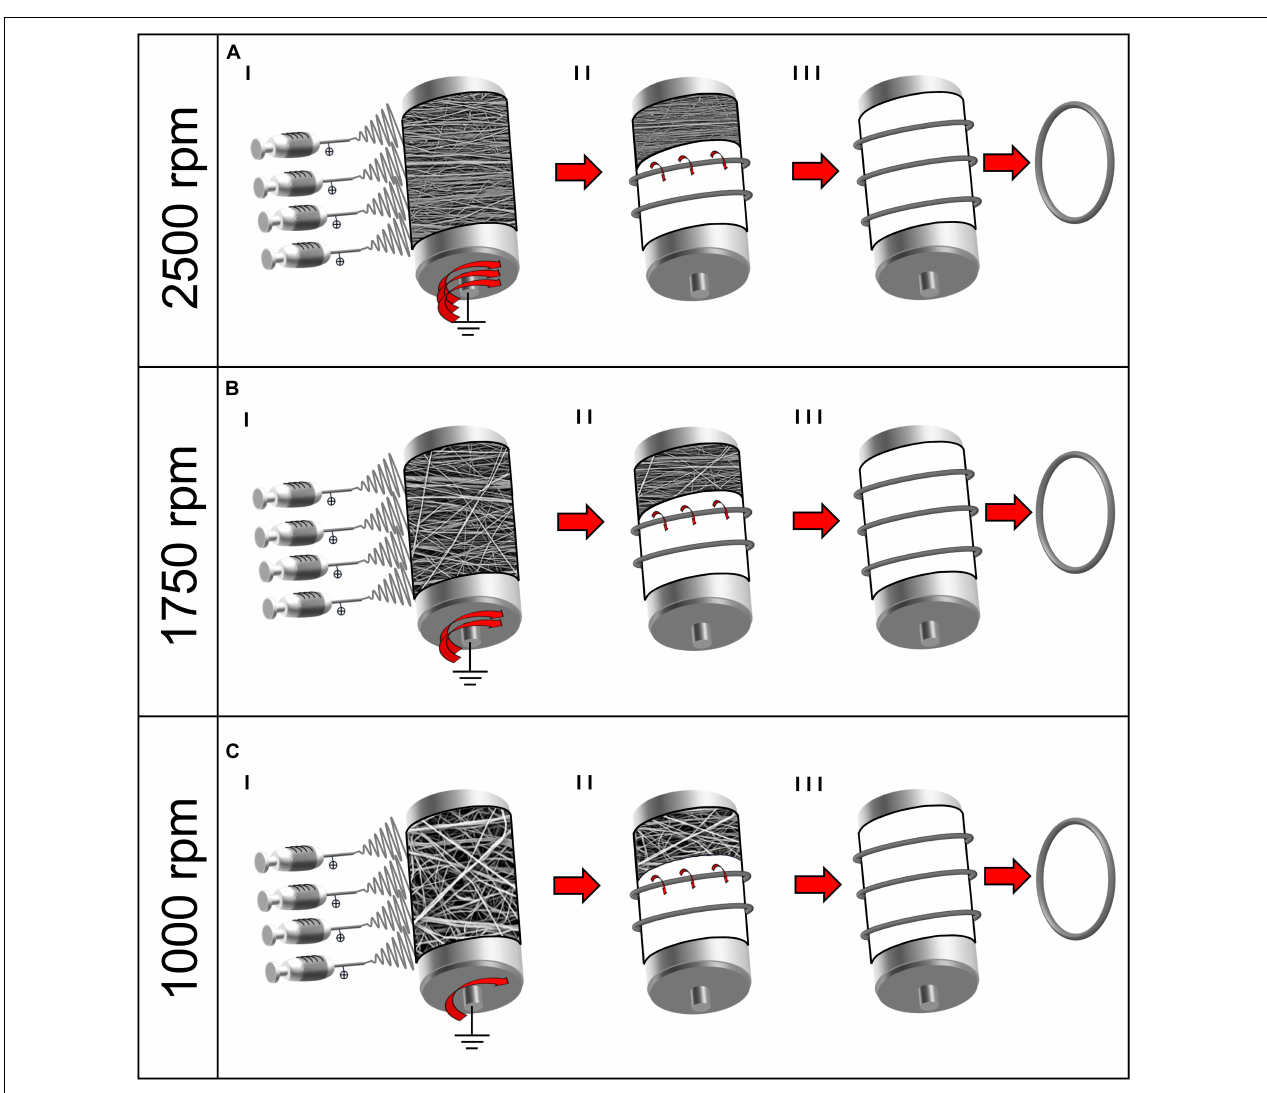
FIGURE 1 | Schematic representation of the electrospinning procedure for the bundle production: (A) 2,500 rpm; (B) 1,750 rpm; and (C) 1,000 rpm. (I) Mats of nanofibers were electrospun on the rotating drum collector at different speeds. (II) The mats were cut in stripes and rolled on the drum and (III) pulled off the drum obtaining ring-shaped